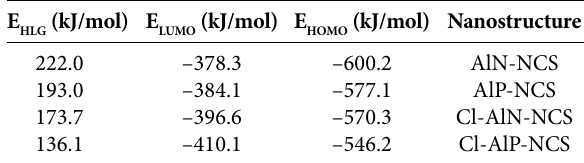
and G of H Se on AlN-NCS, AlP-NCS, Cl- ad ad 2 ad